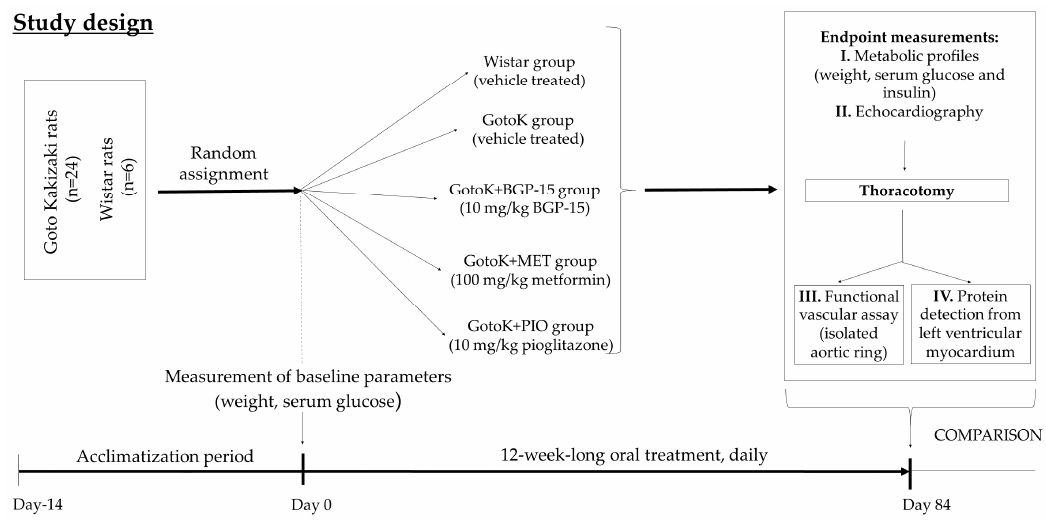
Figure 5. Flow-chart of study design. After acclimatization, healthy control (Wistar) and diabetic GotoK rats were randomly divided into subgroups, as follows: (I) Wistar control, treated with vehicle; (II) diseased GotoK treated with vehicle (GotoK), (III) GotoK treated with 10 mg/kg BGP-15 (GotoK + BGP15), (IV) GotoK trated with 100 mg/kg metformin (GotoK + MET), and (V) GotoK treated with 10 mg/kg pioglitazone (GotoK + PIO), for 12 weeks. At the endpoint, echocardiography was carried out, serum parameters were measured, and after thoracotomy, aortic rings were cut off for ex vivo experiments, and left ventricle myocardium was frozen for further analyses (Western blot).